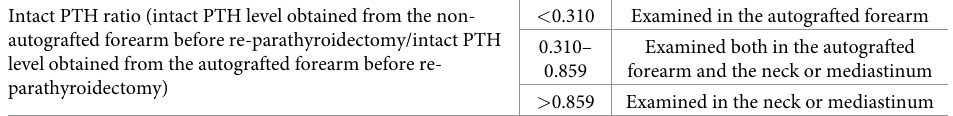
Table 3. Algorithm for the localization of causative parathyroid glands for recurrent or persistent renal hyper- parathyroidism after total parathyroidectomy with forearm